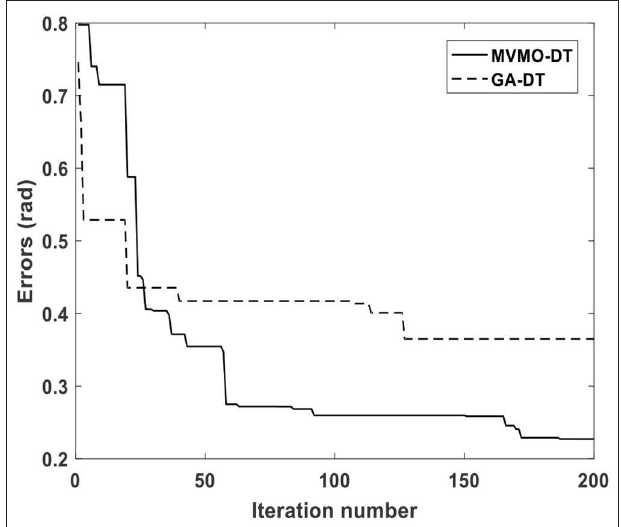
FIGURE 8 | Evolution of DTs errors optimized by MVMO.